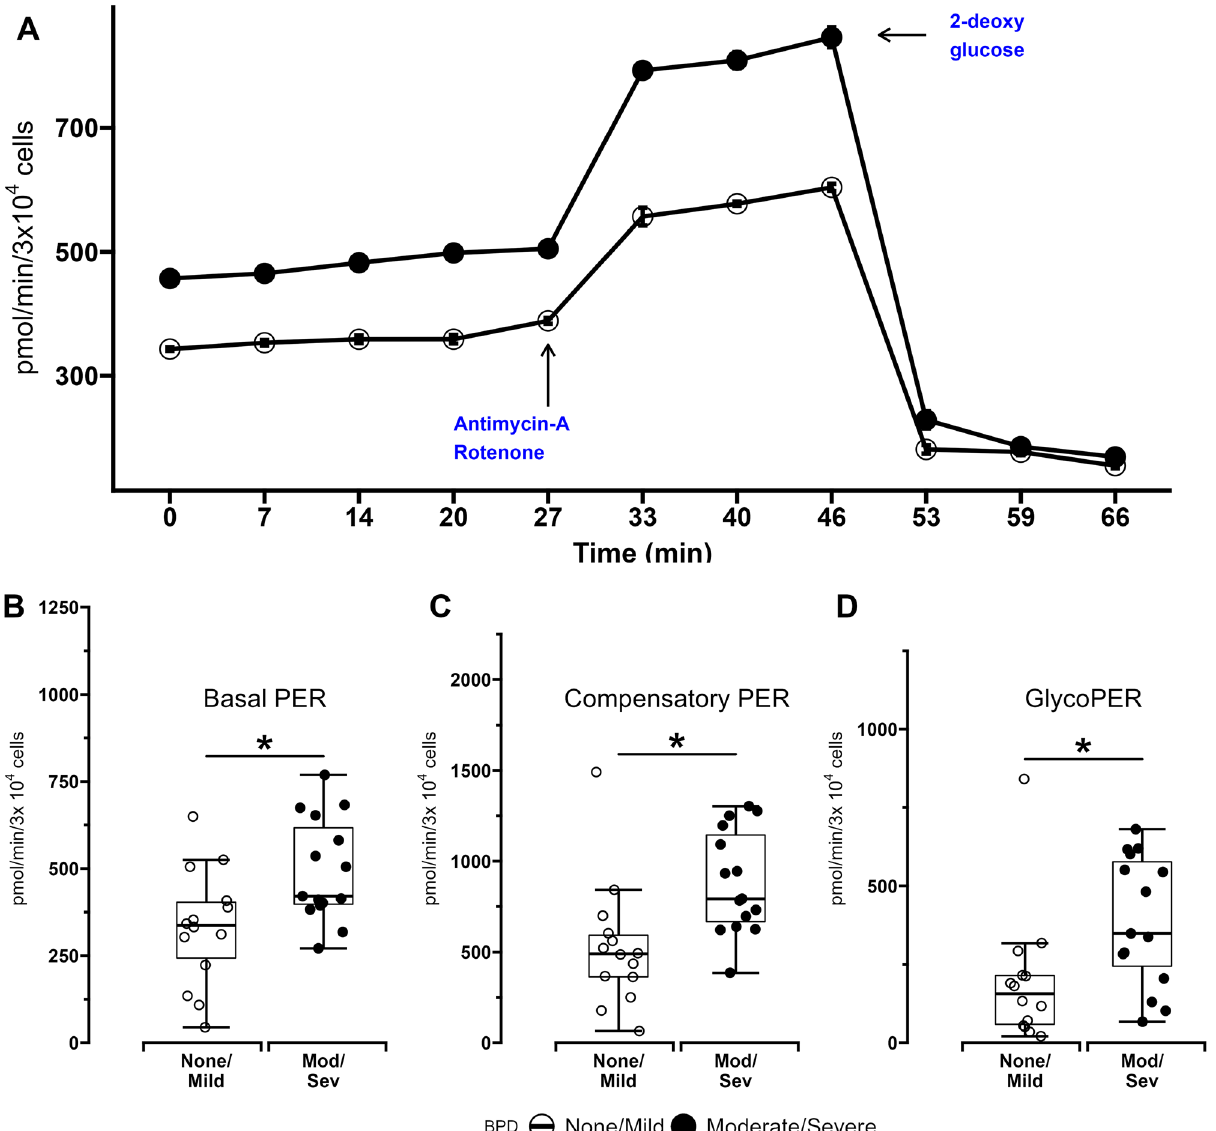
Figure 3. Proton Efflux Rates (ECAR) of MSCs obtained from ELBW infants who died or developed moderate/ severe BPD (Mod/Sev) and ELBW infants who survived with no/mild BPD (None/Mild). ( A ) Representative plot of a typical Proton Efflux Rate (PER) Assay conducted using a Seahorse XF96 flux analyzer. 30,000 cells were seeded per well in 96-well plates, and MSC proton efflux was measured at baseline and in the presence of Antimycin-A. 2-deoxy-glucose was used to confirm that proton efflux was specifically related to cellular glycolysis. ( B ) Basal PER ( C ) Compensatory PER due to antimycin A/rotenone-induced inhibition of mitochondrial respiration ( D ) GlycoPER measured as the difference between basal PER and compensatory PER, indicative of glycolysis-specific PER due to maximal glycolysis measured after oligomycin introduction. Data for all experiments obtained from MSCs from 15 infants with Mod/Sev BPD and 14 with No/Mild BPD. Differences were analyzed using Mann–Whitney U-test and data expressed as median [25th–75th centiles]. * and ** represent p value < 0.05 and < 0.005 respectively. NS —no significant